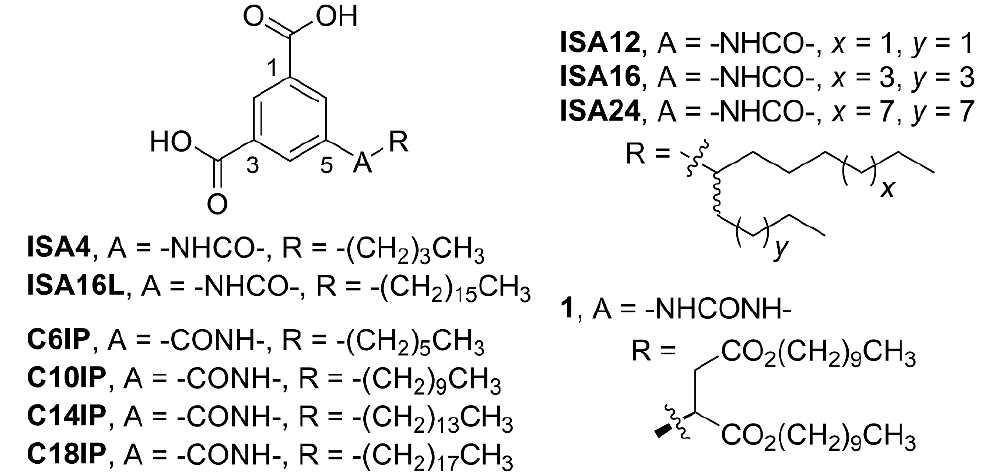
Figure 2. 5-alkylamido isophthalic acid derivatives.